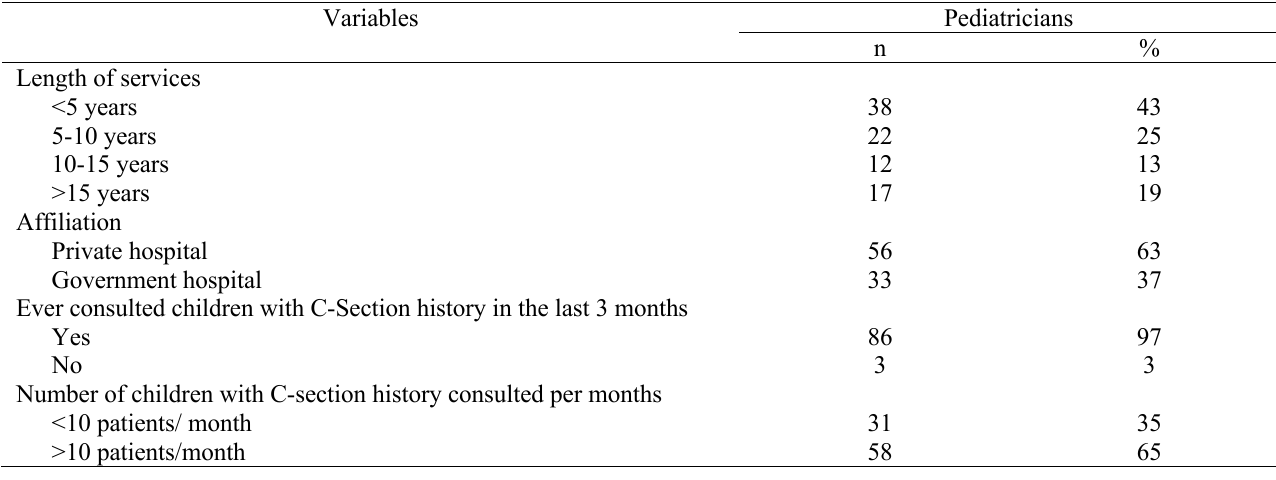
Table 1. Demographic characteristic of respondents